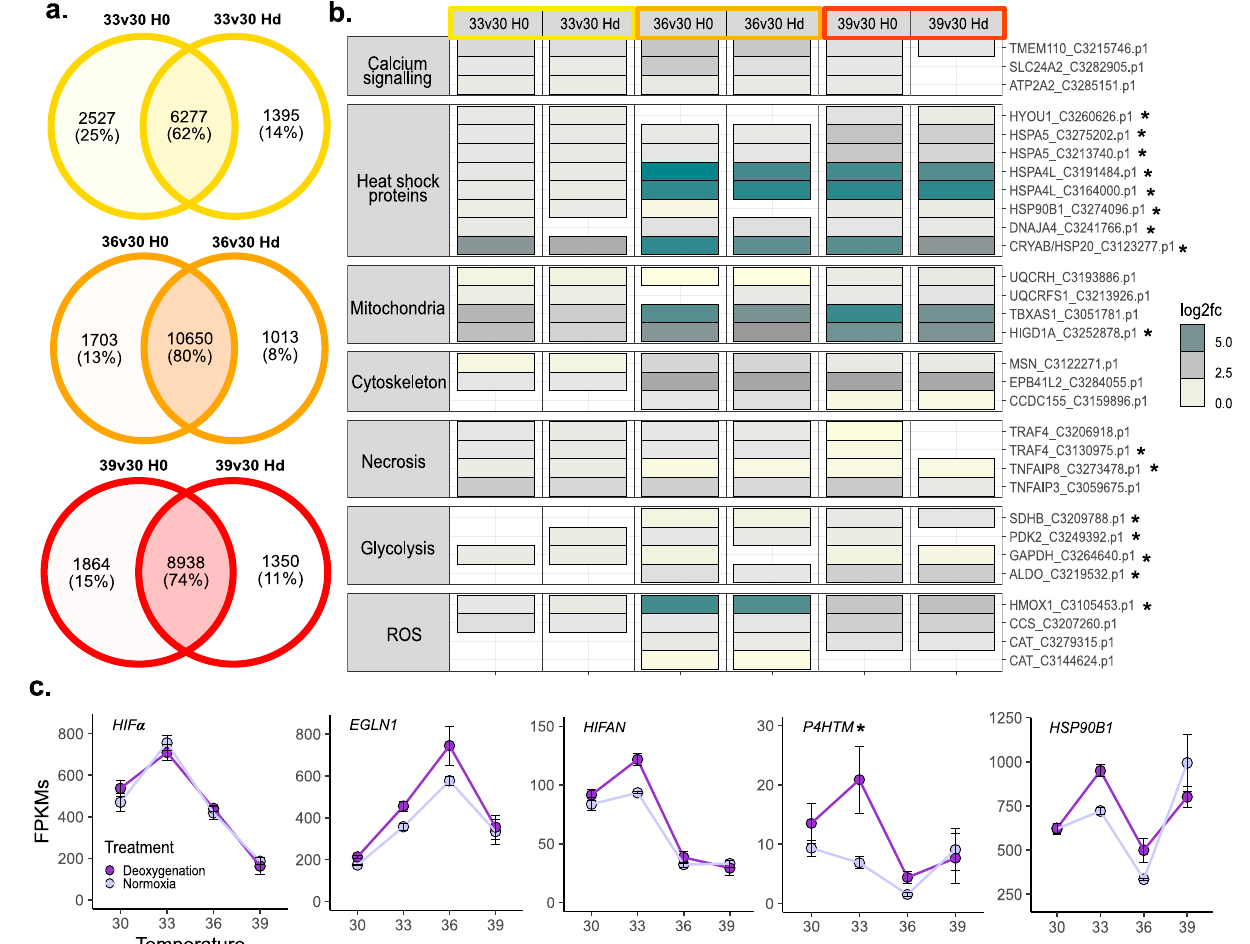
Figure 2. Corals exhibit a similar response to heat stress with and without deoxygenation. ( a) Number (and percentage) of differentially expressed (DE) transcripts at FDR < 0.05 that were common to or unique between normoxic (H0) and deoxygenated (Hd) conditions when comparing heating temperatures (33 °C, 36 °C, 39 °C) to the baseline (30 °C). (b) Log 2 -fold change (FC log2 ) differences in gene expression of common heat stress genes under normoxic and deoxygenated heat stress. Considered DE transcripts are associated with calcium signalling, heat shock proteins, mitochondria, cytoskeletal restructuring, necrosis, glycolysis promotion, and ROS mitigation. Colour gradient indicates log 2 -fold change, where green and yellow represent a positive and negative fold change, respectively. White space indicates no DE. Asterisks indicate those transcripts also reported under deoxygenation stress in coral 25,34 . (c) Expression dynamics across temperatures for both conditions (H0 and Hd) for hypoxia-inducible factor alpha subunit ( HIFα ), prolyl hydroxylase domain 2/4 ( EGLN1 / P4HTM ), HIFα inhibitor ( HIFAN ), and heat shock protein 90 ( HSP90B1 ). Expression estimates are based on fragments per kilobase of transcript per million mapped reads (FPKM). Error bars denote standard error with n = 4 for each